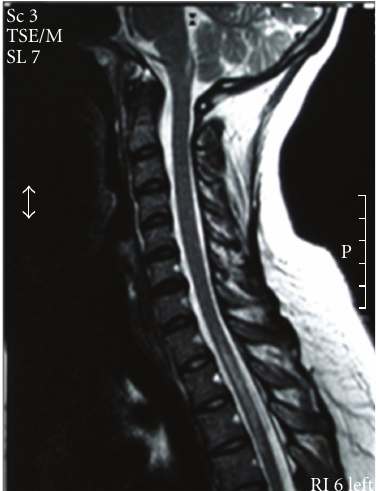
Figure 1: Sagital T2-MRI of the spinal cord showing an extensive enhancing thoracic lesion